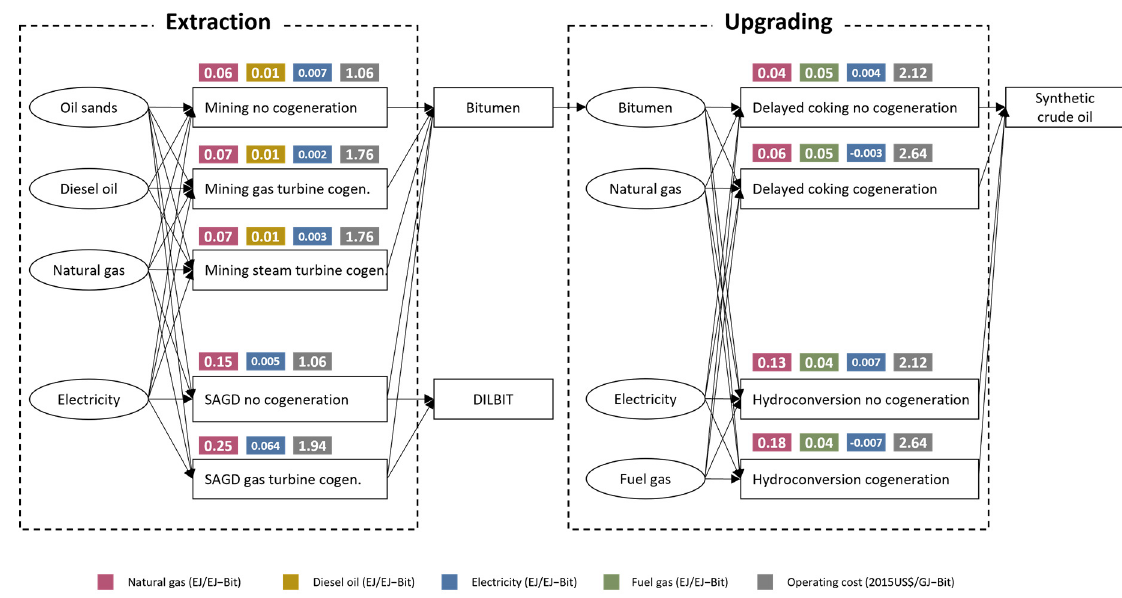
Figure 2. Energy inputs and operating costs in oil sands